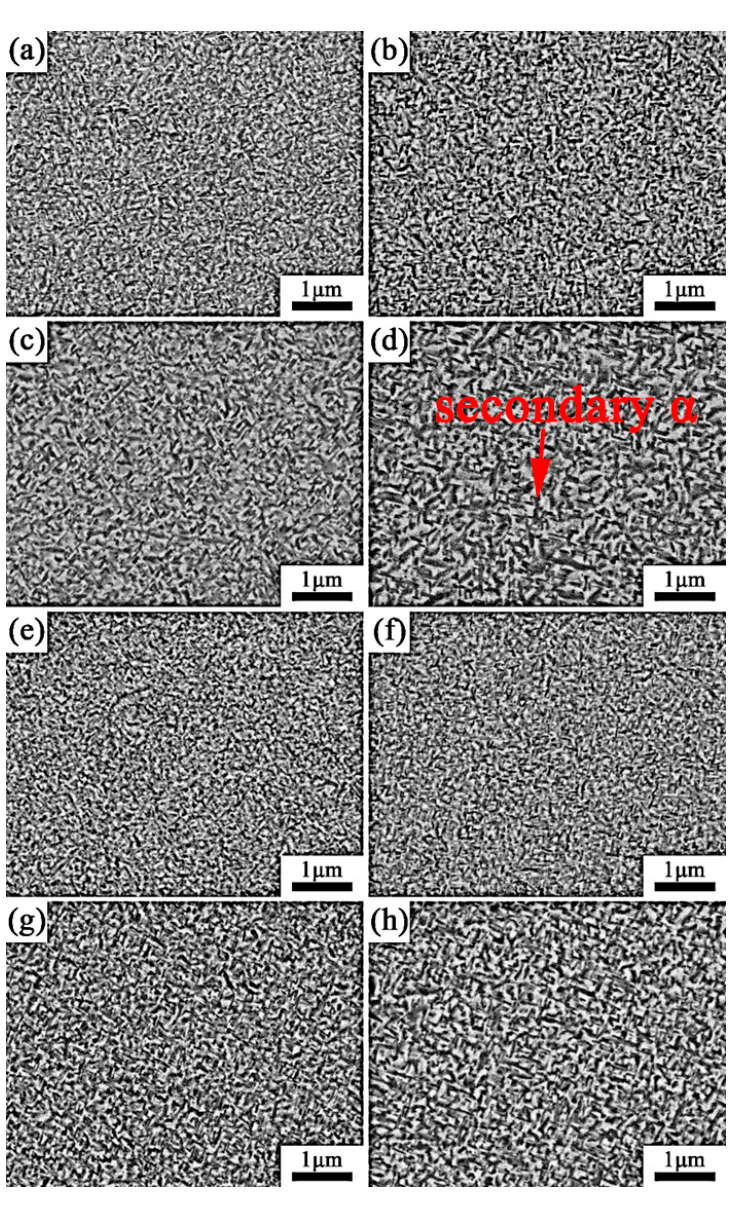
Figure 7. Microstructures of the alloy after solution treatment for 0.5 h and aged for 8 h: ( a ) 820 °C + 500 °C; ( b ) 820 °C + 520 °C; ( c ) 820 °C + 540 °C; ( d ) 820 °C + 560 °C; ( e ) 840 °C + 500 °C; ( f ) 840 °C + 520 °C; ( g ) 840 °C + 540 °C; ( h ) 840 °C + 560 °C.